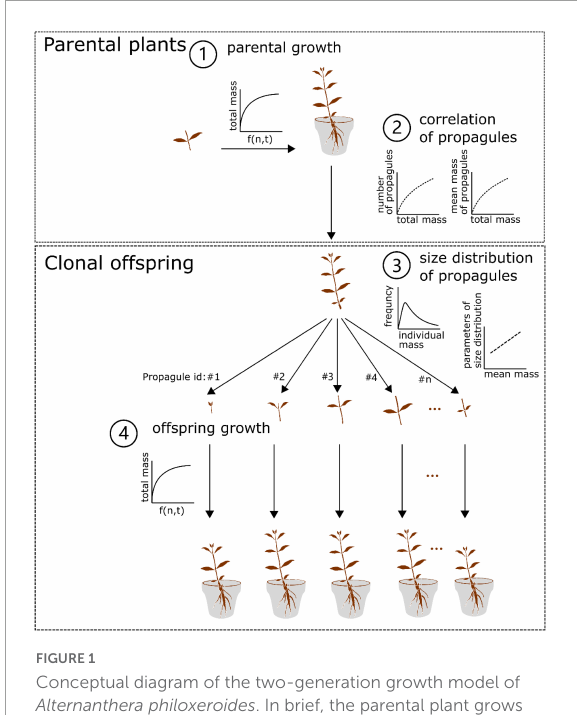
FIGURE1 Conceptual diagram of the two-generation growth model of Alternanthera philoxeroides . In brief, the parental plant grows following the setup of the three-parameter logistic model with N levels and time included (1), and the final (total) mass of the parental plant is non-linearly correlated with the number and mean mass of its clonal propagules (2). In addition, the size of the surviving clonal propagules produced by the parental plant followed the Weibull distribution, in which the scale and shape values are linearly correlated with the mean mass of the surviving clonal propagules (3). The surviving offspring continue to grow following the setup of the growth model for the parental plant (4). See details in the Material and Method